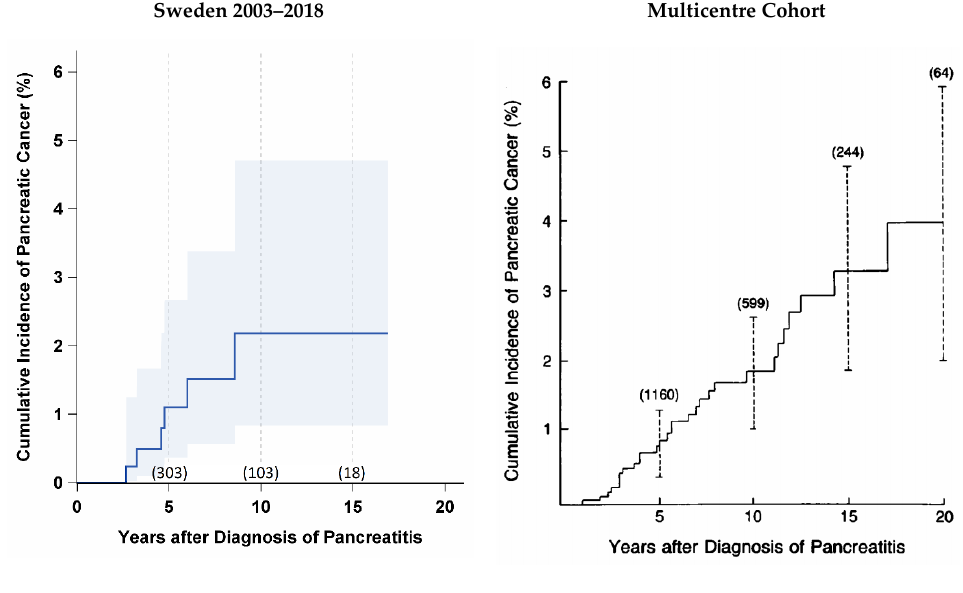
Figure 2. Cumulative incidence of pancreatic cancer in Sweden compared to the multicentre cohort study. The number in parenthesis indicates the number of patients at risk at different time points .